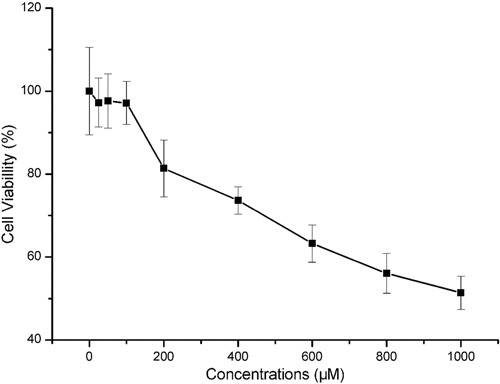
Percentage of viable of HeLa cells at different Cu-His concentrations.
Cellular viability was analyzed using the MTT assay. Cu-His at different
concentrations (200, 400, 600, 800, and 1000 μM) inhibited cell viability by
approximately 20%-50% (P<0.01,t-test), but not for
concentrations under 100 μM (n=8) (P>0.05). The results were reported
relative to the response of the negative control cells. MTT,
3-(4,5-dimethylthiazol-2-yl)-2,5-diphenyltetrazolium bromide.